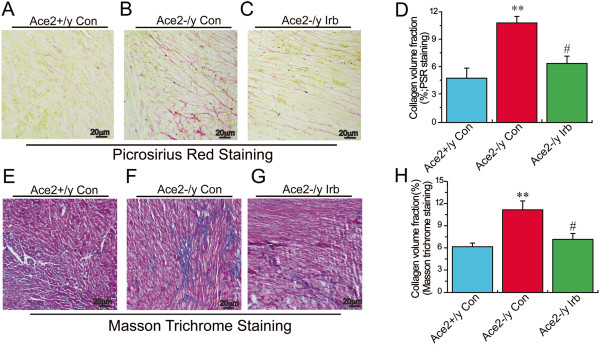
Effects of irbesartan on myocardial fibrosis in ACE2KO mice. Representative images of Picrosirius red (A−D) and Masson trichrome (E−H) staining showed myocardial fibrosis and collagen volume fraction (CVF) were attenuated in irbesartan (Irb)-treated Ace2-/y mice than in Ace2-/y control mice (×100 magnification). n = 4 for each group. **P < 0.01 compared with Ace2+/y control group; #, P < 0.05, compared with Ace2-/y control group.